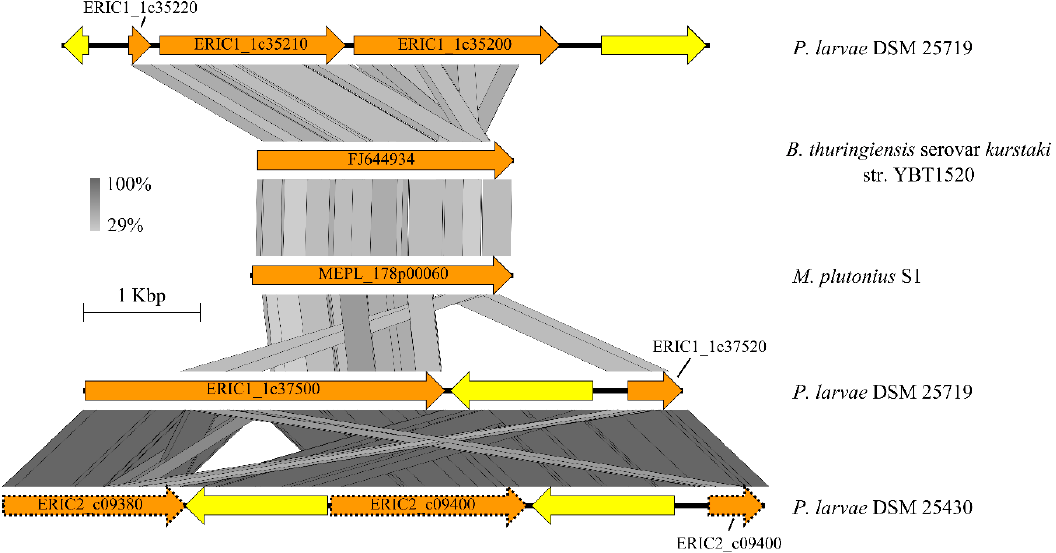
Figure 5. Comparison of the enhancin gene cluster of M. plutonius S1 with P. larvae DSM 25719, Paenibacillus larvae DSM 25430 and Bacillus thuringiensis serovar kurstaki str. YBT1520. The graphical presentation was done with the Easyfig software (minimum blast hit length of 50 bp) [43]. ORFs depicted as dotted arrows represent pseudogenes. ORFs related to enhancin are orange, and transposases are shown in yellow.